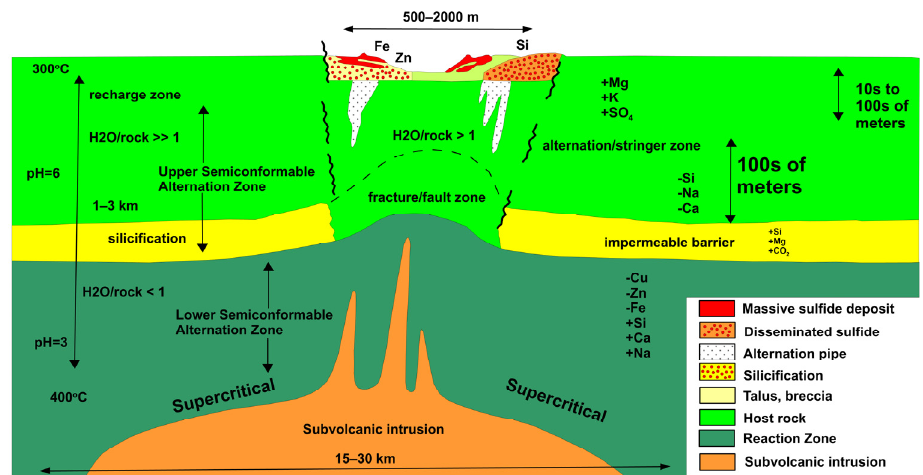
Figure 3. Display of factors, resulting in the massive sulfide ore deposits formation [41].